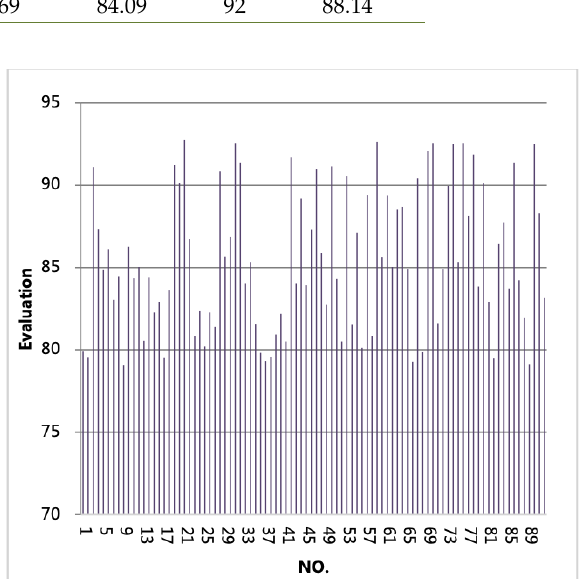
Fig. 3. Statistical diagram of the evaluation of data mining ability Fig. 4. Statistical diagram of evaluation of Guilin